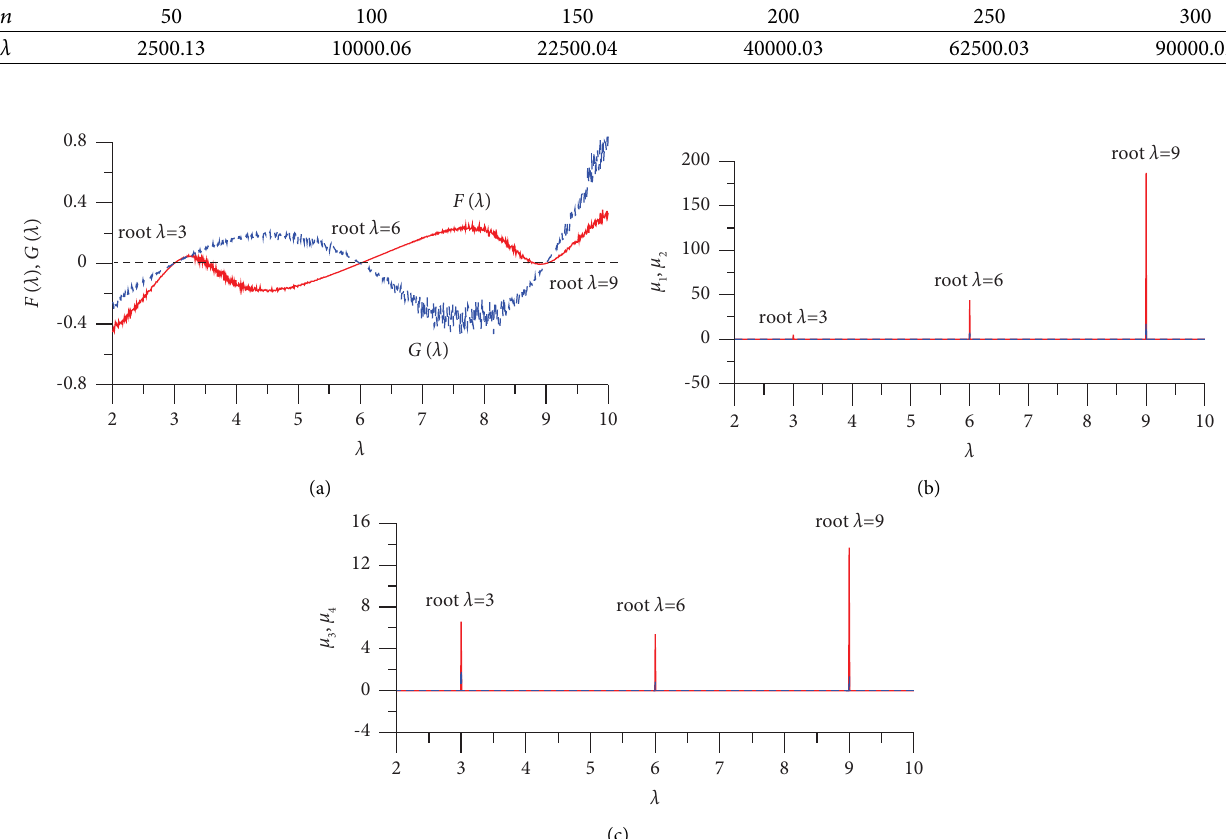
and μ , and (c) the peaks of 1 2